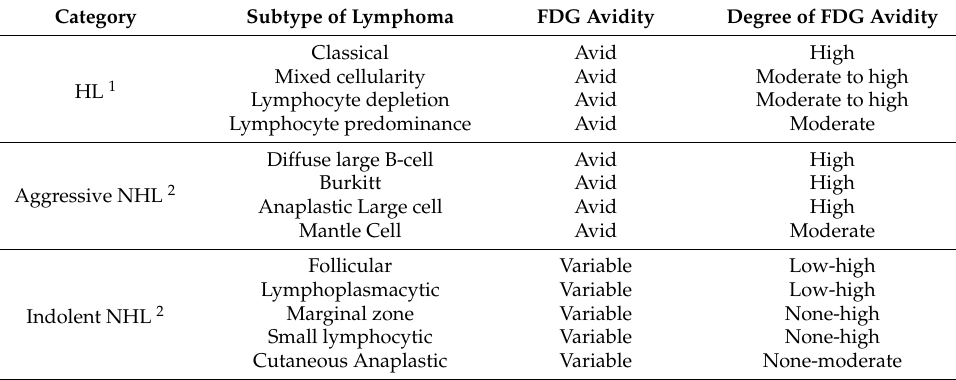
Cutaneous Anaplastic Variable